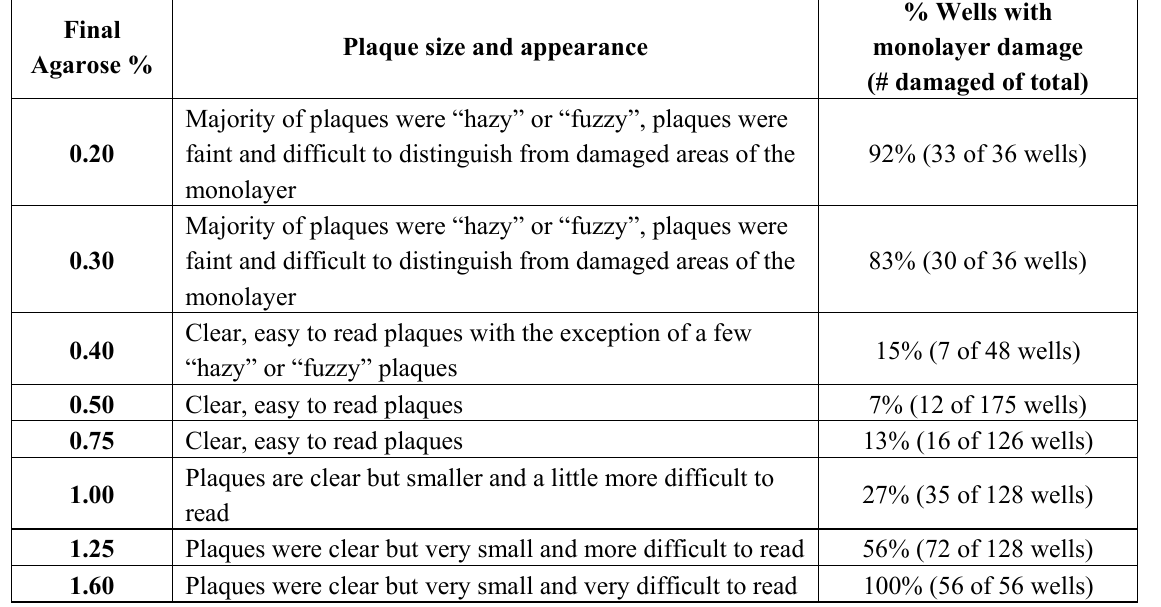
Table 1. EBOV plaques appeared clear and easily countable when a final concentration of 0.5% agarose is applied to the wells. Data were collected in three experiments, where three to six replicate wells were observed for agarose concentration